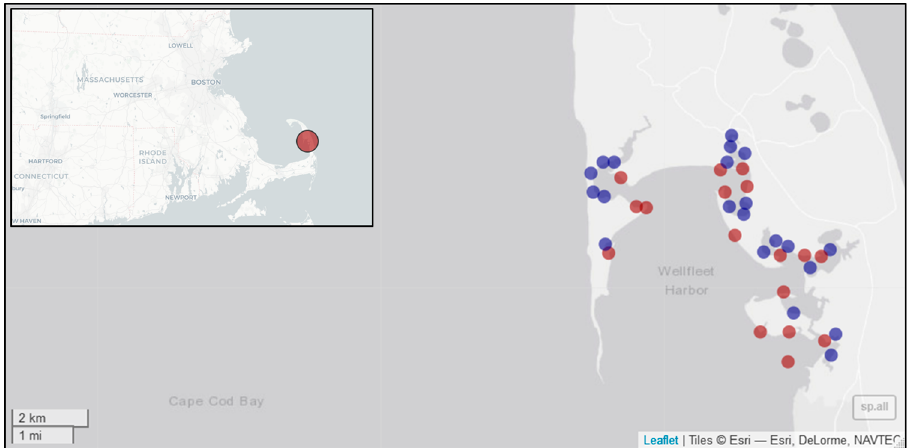
Figure 1. The Wellfleet Bay study area. Circles in the main figure show the location of the 38 visual head count surveys (Red: exposed, Blue: sheltered), while the inset shows the geographic location of Wellfleet Bay in the greater Cape Cod Bay, Massachusetts.